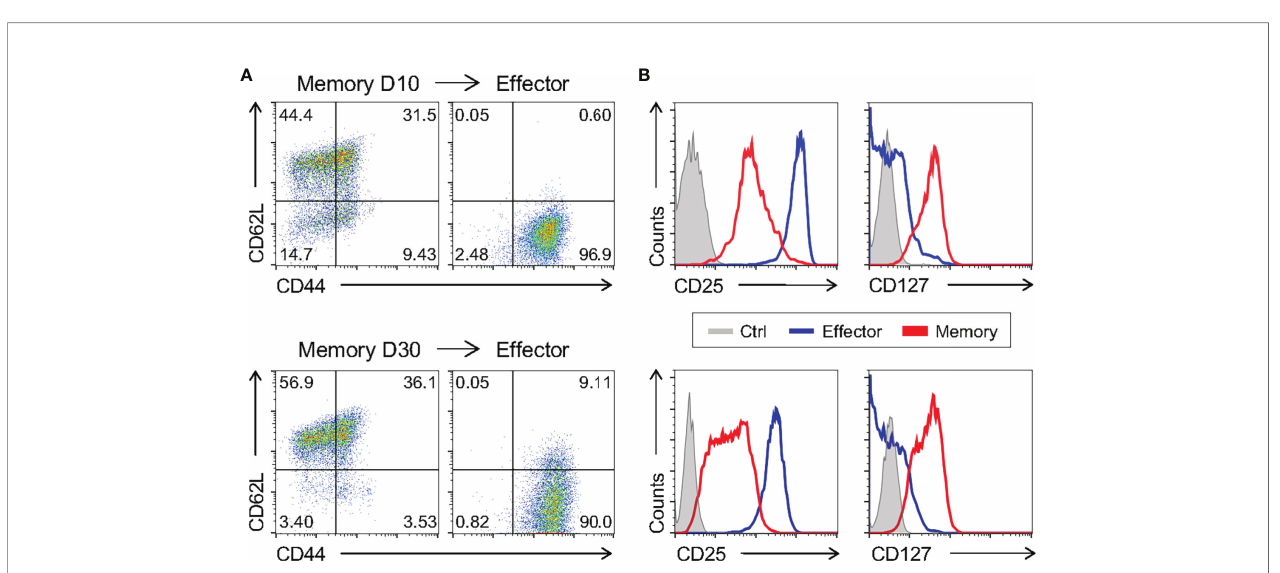
FIGURE 6 | Memory CD8 T Cells Differentiated In Vitro Are Capable of Generating Effector Cells. The ten- and thirty-day memory CD8 T cells generated in vitro were reactivated applying an adapted model of the in vitro effector differentiation protocol for three days of culture. (A, B) The memory cells cultured for 10 days (above) and 30 days (below) and the effector cells reactivated from their respective memory were labeled with CD44, CD62L, CD127 and CD25 fl uorescently labeled monoclonal antibodies. All results are representative of two or three independent experiments. Ctrl: unlabeled (gray); effector (blue); memory